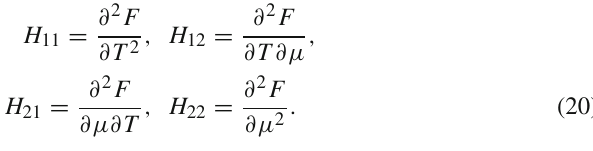
= 0 ( red solid ), α = 0, 1